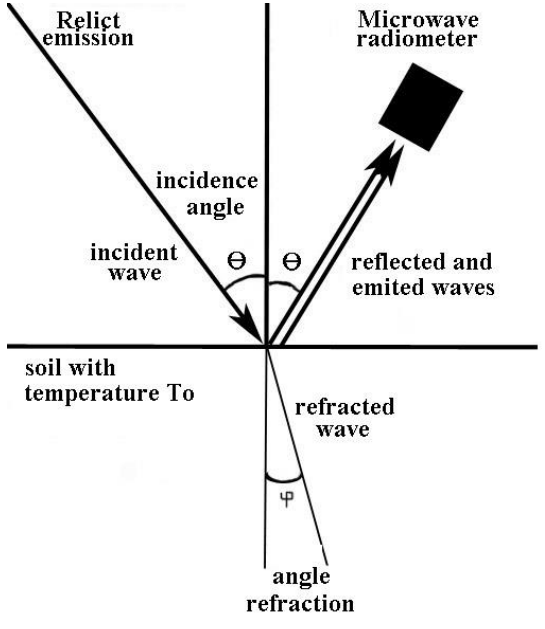
Fig. 1. The location of microwave